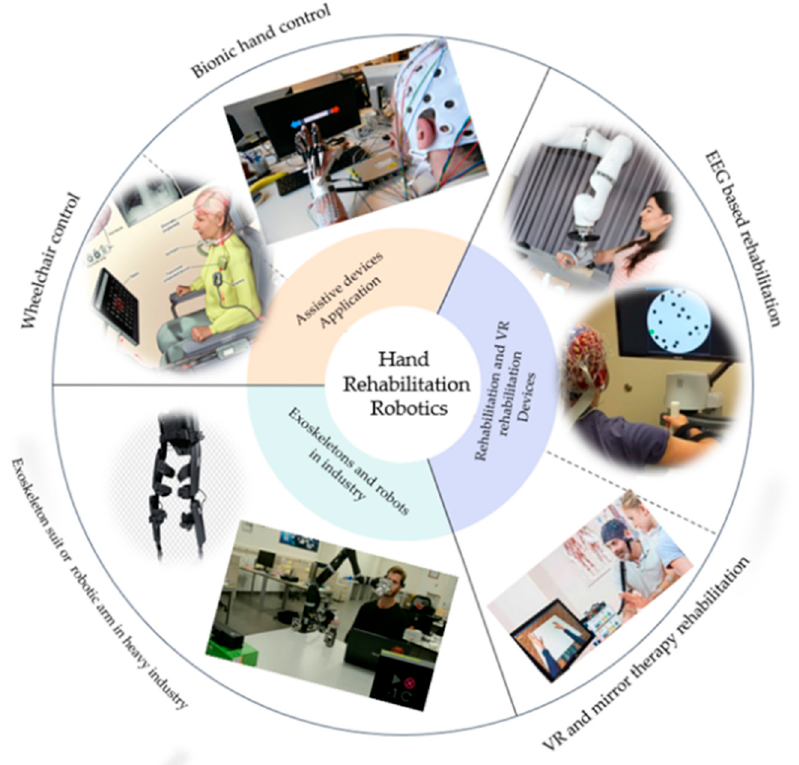
Figure 6. Application of the BCI system.